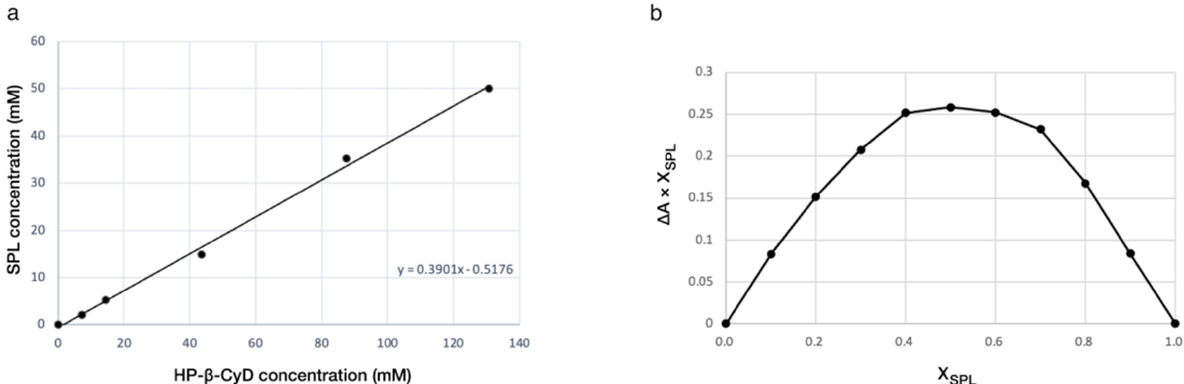
Figure 1. ( a ) Phase solubility diagram of SPL with HP- β -CyD in water at 25 °C; ( b ) Job’s Plot for 1:1 complex of SPL with HP- β -CyD in water at 25 °C.